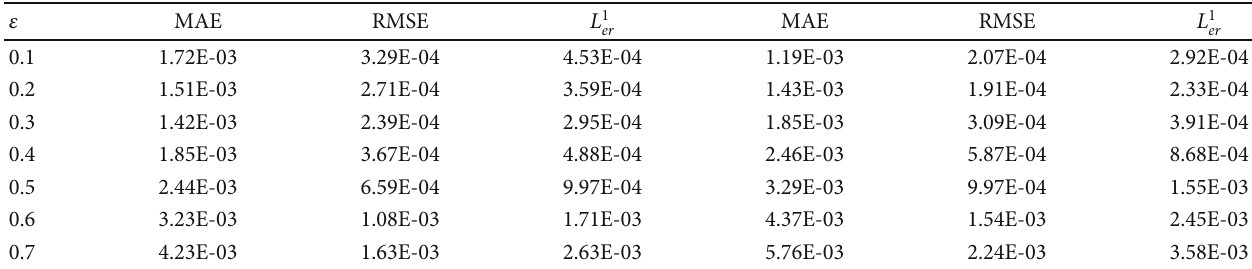
Table 8: Results for di ff erent values of ε in Example 2 with N conditions.